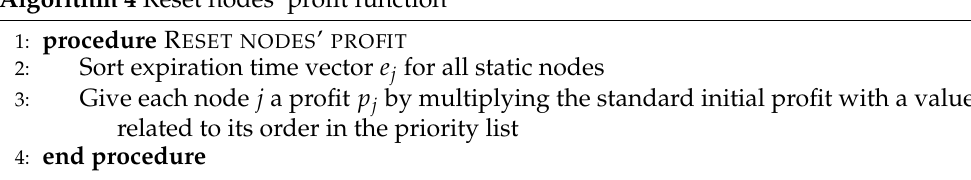
Algorithm 4 Reset nodes’ profit